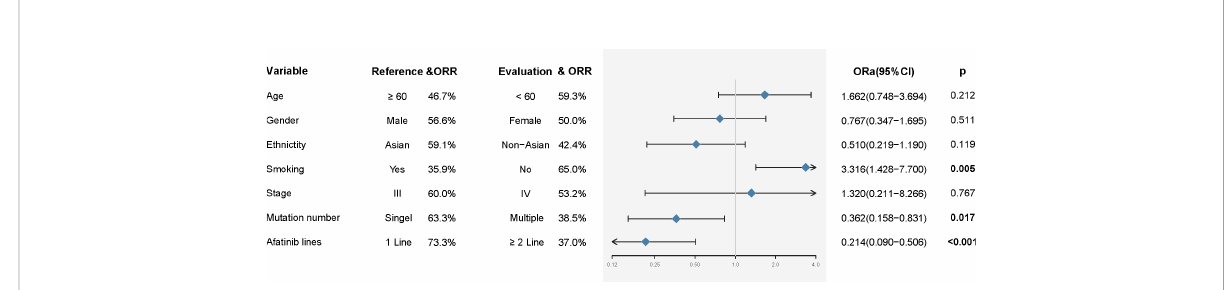
FIGURE 3 Univariate analysis for treatment response. ORR, Objective response rate; ORa, Odds ratio.